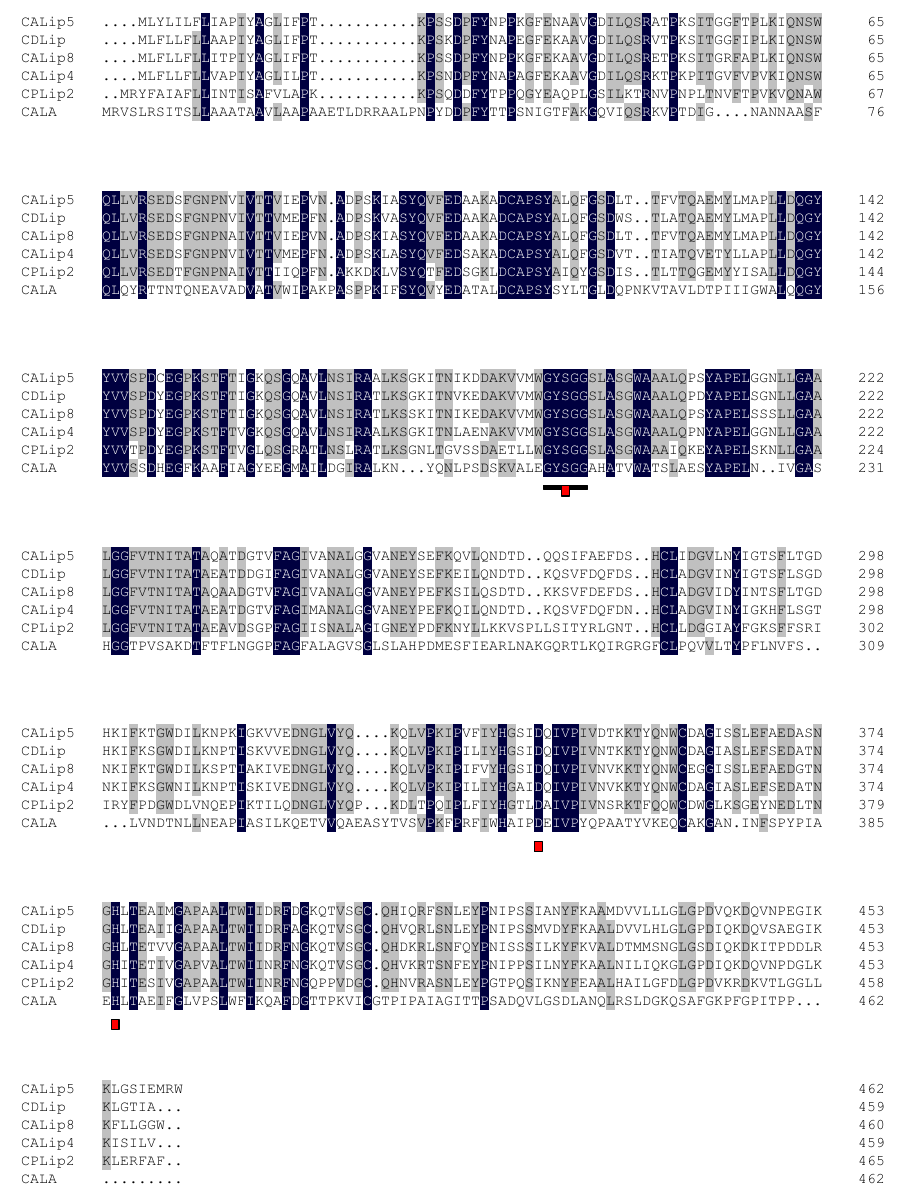
Figure 1. Multiple alignment of Lip5-DM (CALip5) amino acids sequence